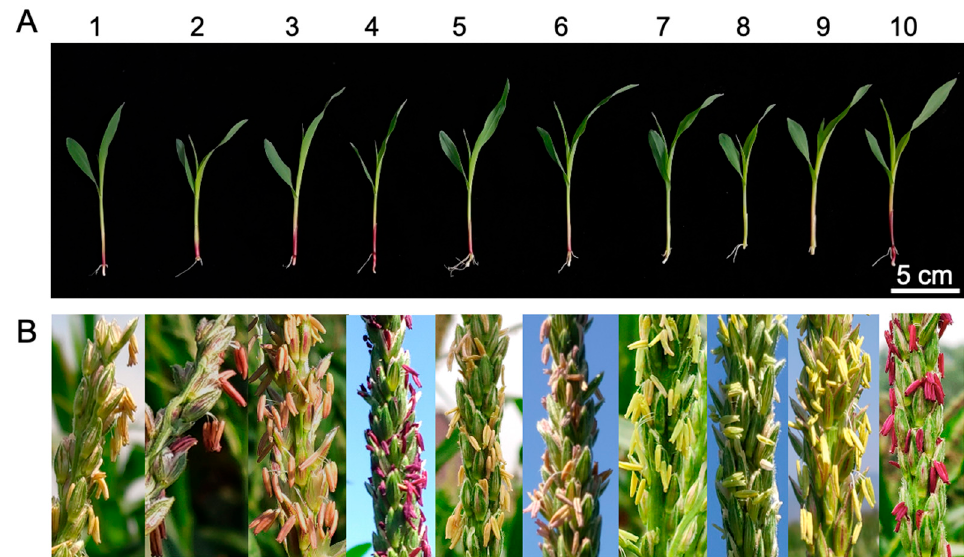
Figure 2. T 2 transgenic seedlings and their anther phenotypes. ( A ) Representative T 2 seedling phenotypes. ( B ) Representative anthers of T 2 transgenic plants. 1, S3-Hel1613; 2, S3-Hel1158, 3, S3-HelA2; 4, S1-Hel1-4; 5, S2-Hel1-4; 6, S3-Hel1-4; 7, S4-Hel1-4; 8, B104 donor line; 9, Hi II donor line; 10, positive C1 transgenic line. Table 1. Sequence features of dHel-GFP constructs and pigmentation phenotypes of T 2 transgenic plants and F 1 segregants of test cross